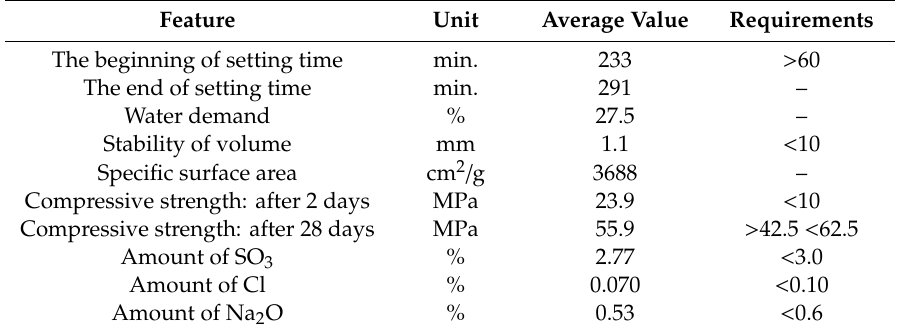
Table 1. Table 1. Physico–chemical parameters of the CEM I 42.5N–SR3 / NA (based on the manufacturer’s